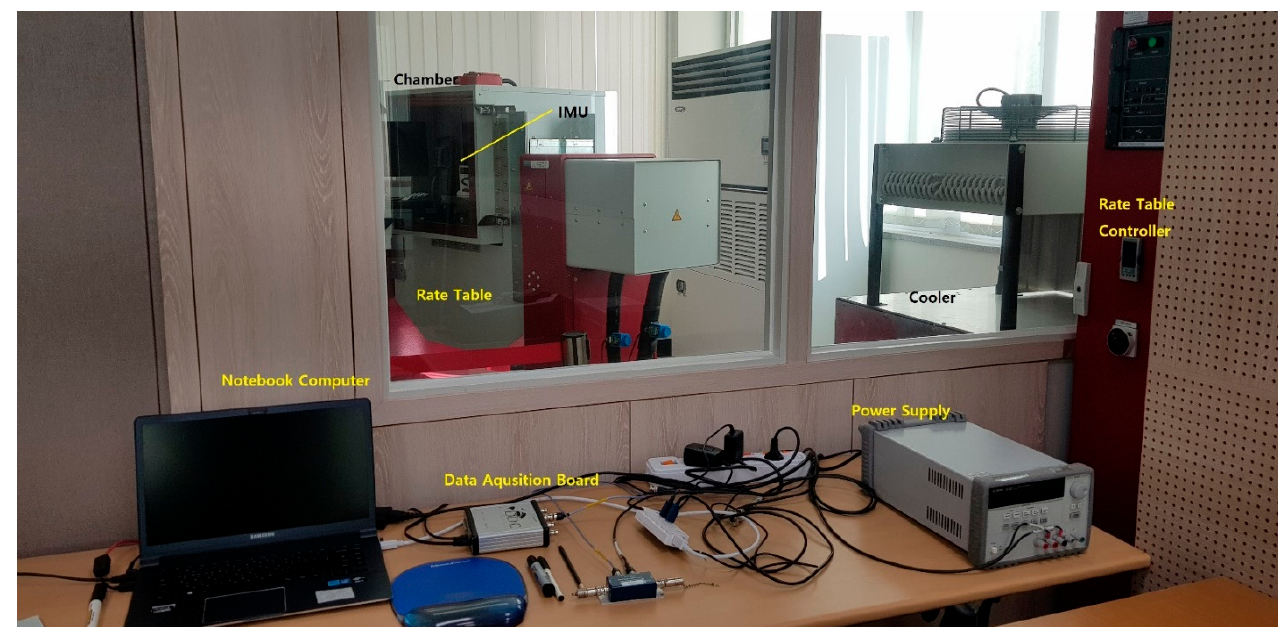
Figure 7. Experimental setup.